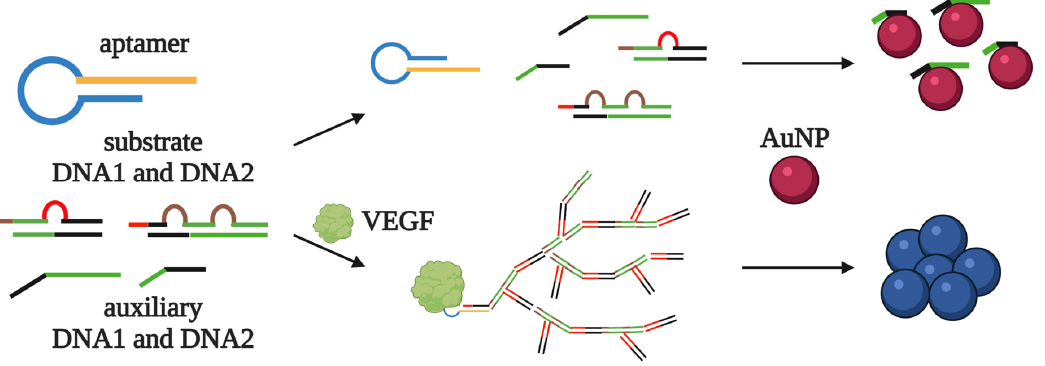
Figure 4. AuNP ‐ based aptasensor for VEGF detection with signal amplification proposed by C.C. Chang [19]. The aptasensor consists of aptamer ‐ containing hairpin DNA, two DNA substrates, and